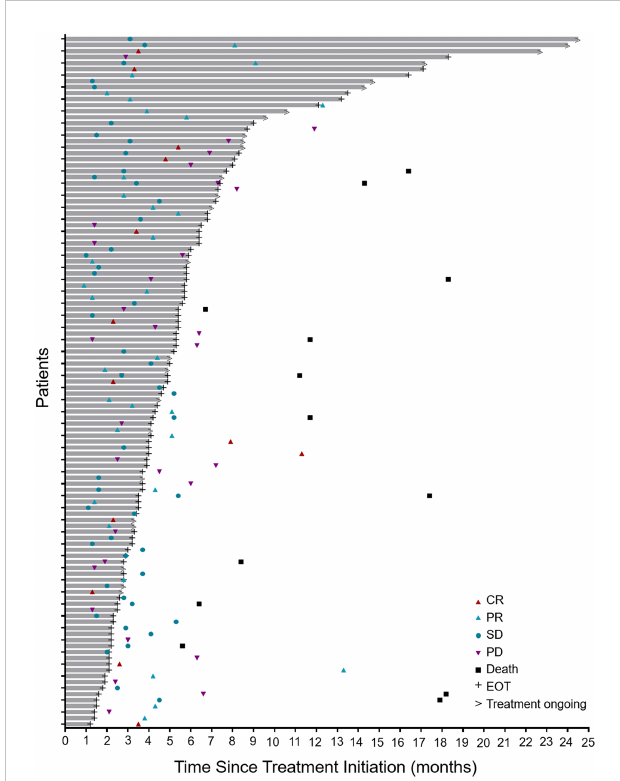
FIGURE 1 Antitumor activity. Duration of the responses of all treated patients (n = 115). The length of each bar represents the duration of Tislelizumab treatment for each patient. CR, complete response; PR, partial response; SD, stable disease; PD, progressive disease; EOT, end of